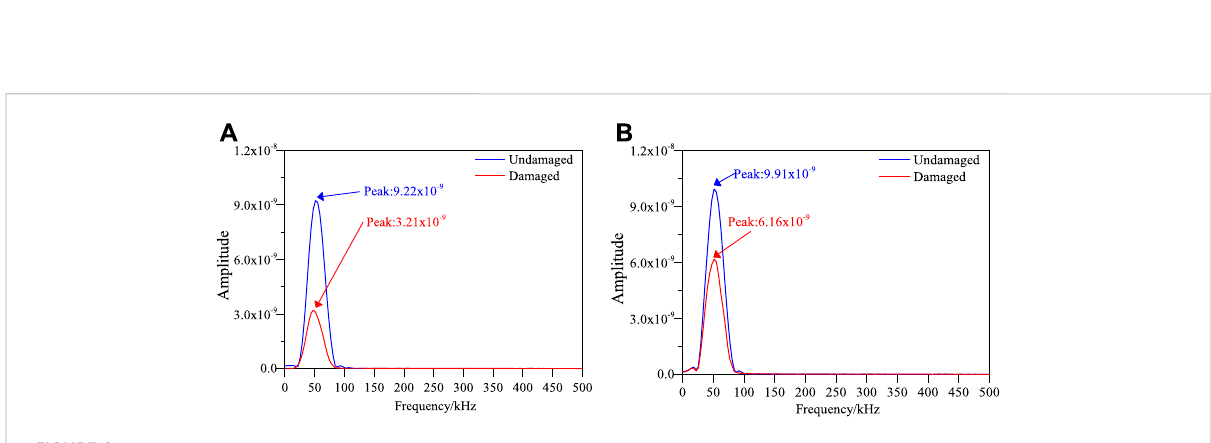
FIGURE 9 Comparison of frequency spectrum of signals before and after damage. (A) S1 − S7 single sensing channel. (B) S5 − S9 single sensing